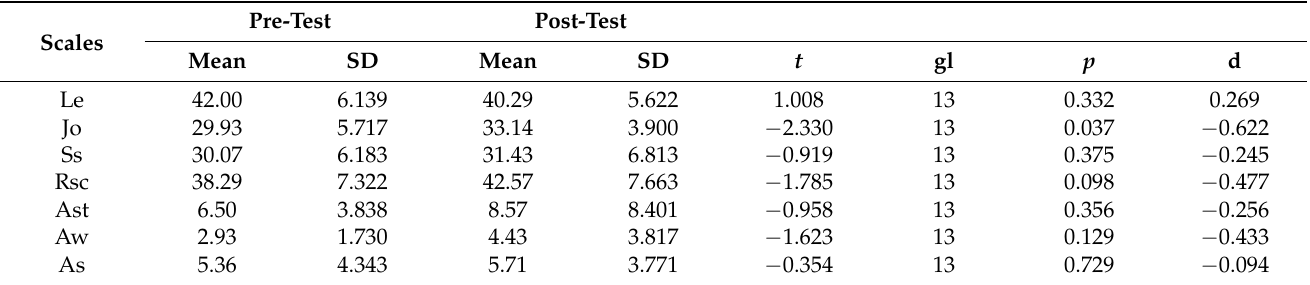
Table 8. Scores obtained in the parents’ BAS at the beginning and end of the fifth grade of primary school.